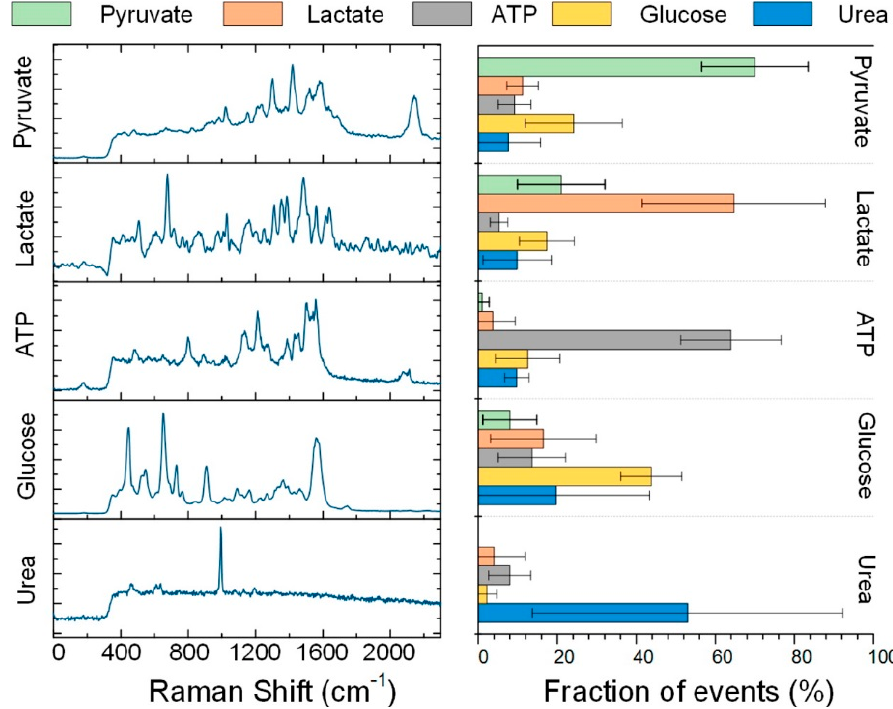
Figure 56. SERS spectra of pyruvate, L-lactate, adenosine triphosphate (ATP), D-glucose, and urea generated by principal component analysis (PCA) of a standard solution (left). These spectra were used to build SERS spectra database. Evaluation of the selectivity of the chemometric algorithm (right). SERS measurements were performed on five SERS nanosensors with a fresh standard solution of the target molecule. The error bars indicate standard deviation. Reproduced with permission from Lussier et al. [459]; further permissions related to the material excerpted should be directed to the ACS. Copyright (2016), the American Chemical Society.